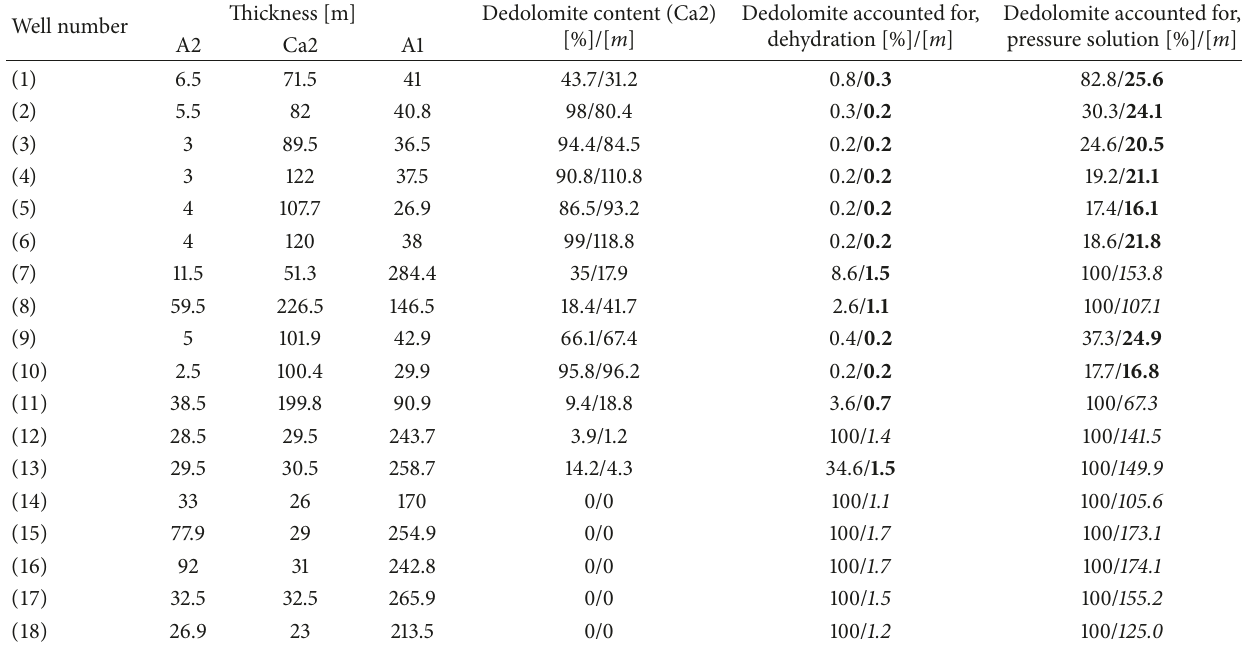
Table 1: List of wells used for the estimation of the dedolomitization potential of gypsum dehydration within the study area. The amount of dedolomite within each well which is accounted for by the dehydration fluids or pressure solution is expressed as percentage and in absolute values. Values in bold indicate an insufficiency of dedolomitizing fluids while italic values represent overabundance of dedolomitizing fluids. Thickness [m] Dedolomite content (Ca2) Dedolomite accounted for, Dedolomite accounted Well number [%]/[ m ]